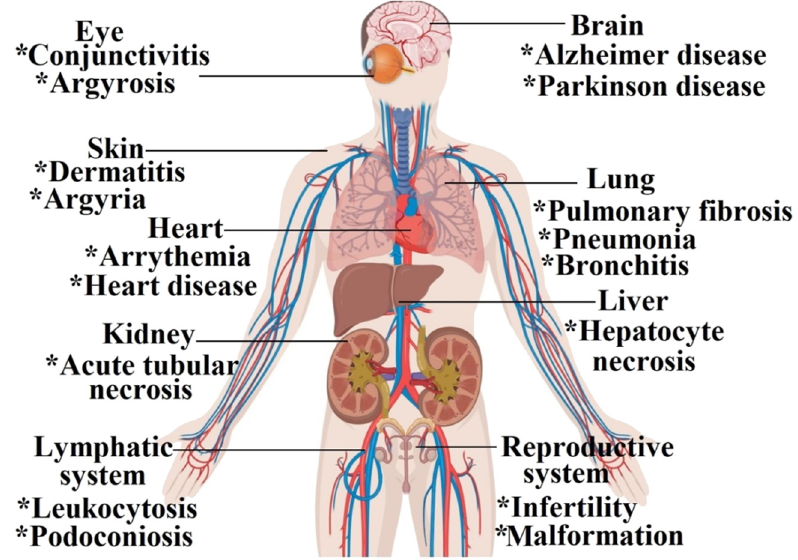
Figure 9: The related diseases after exposure to the toxic level of silver NPs.